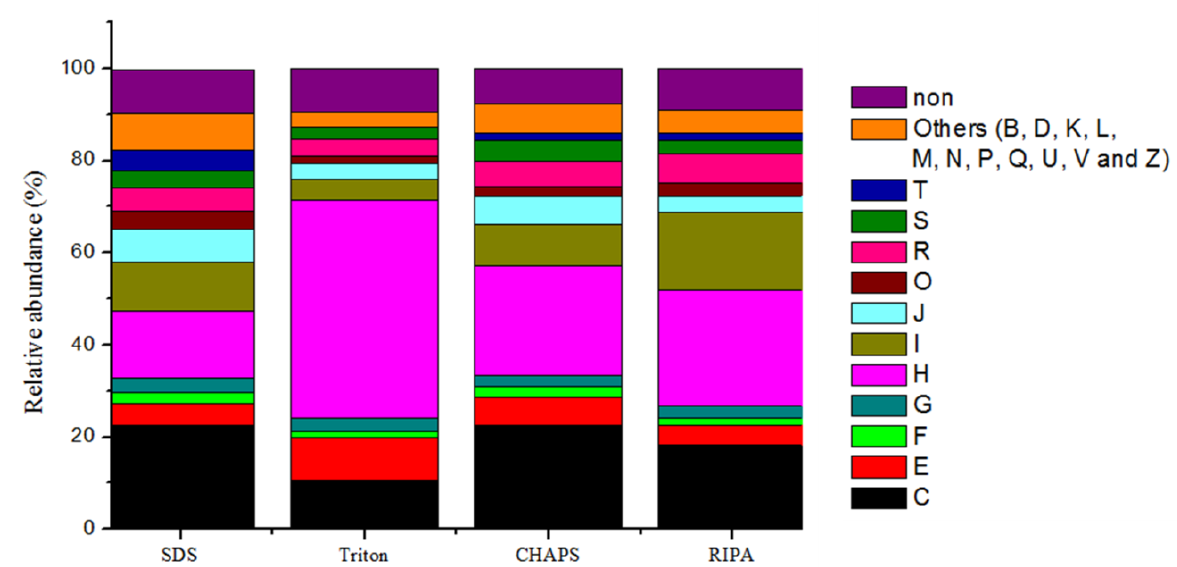
Figure 6. Comparison of the relative abundance of the identified proteins assigned to the functional categories based on cluster of orthologous groups (COG)